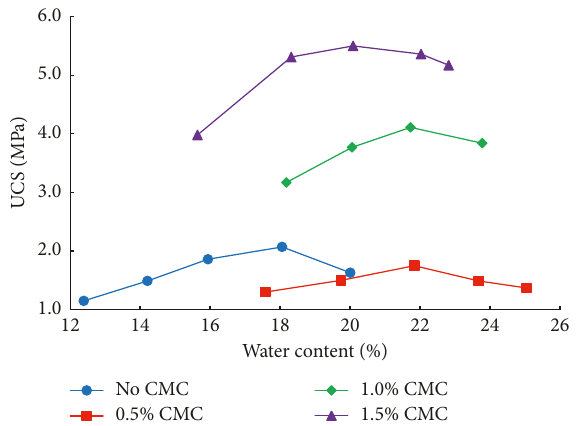
Figure 5: Moisture-UCS relation for CMC-stabilized soil.